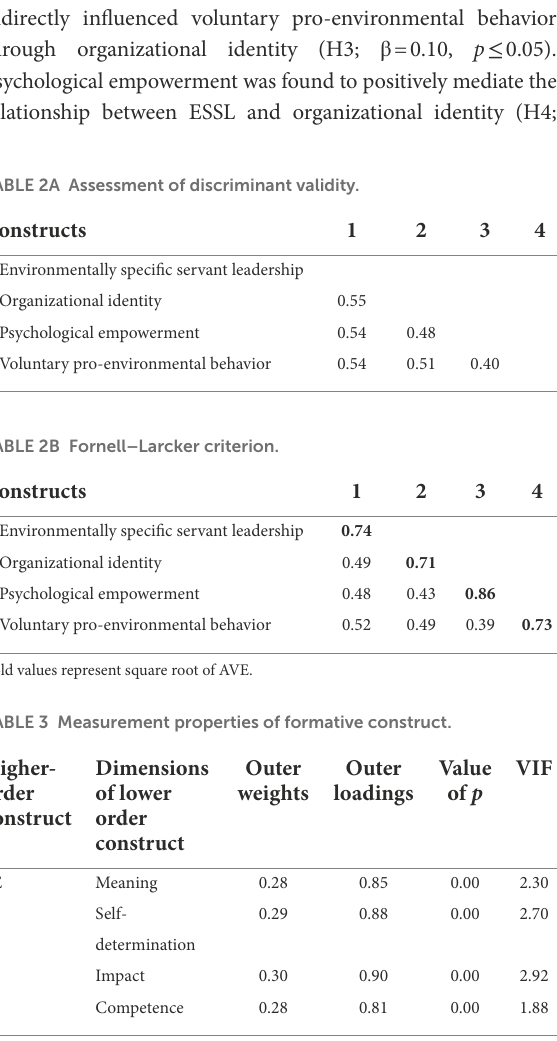
PE, Psychological empowerment; VIF, Variance inflation factor.